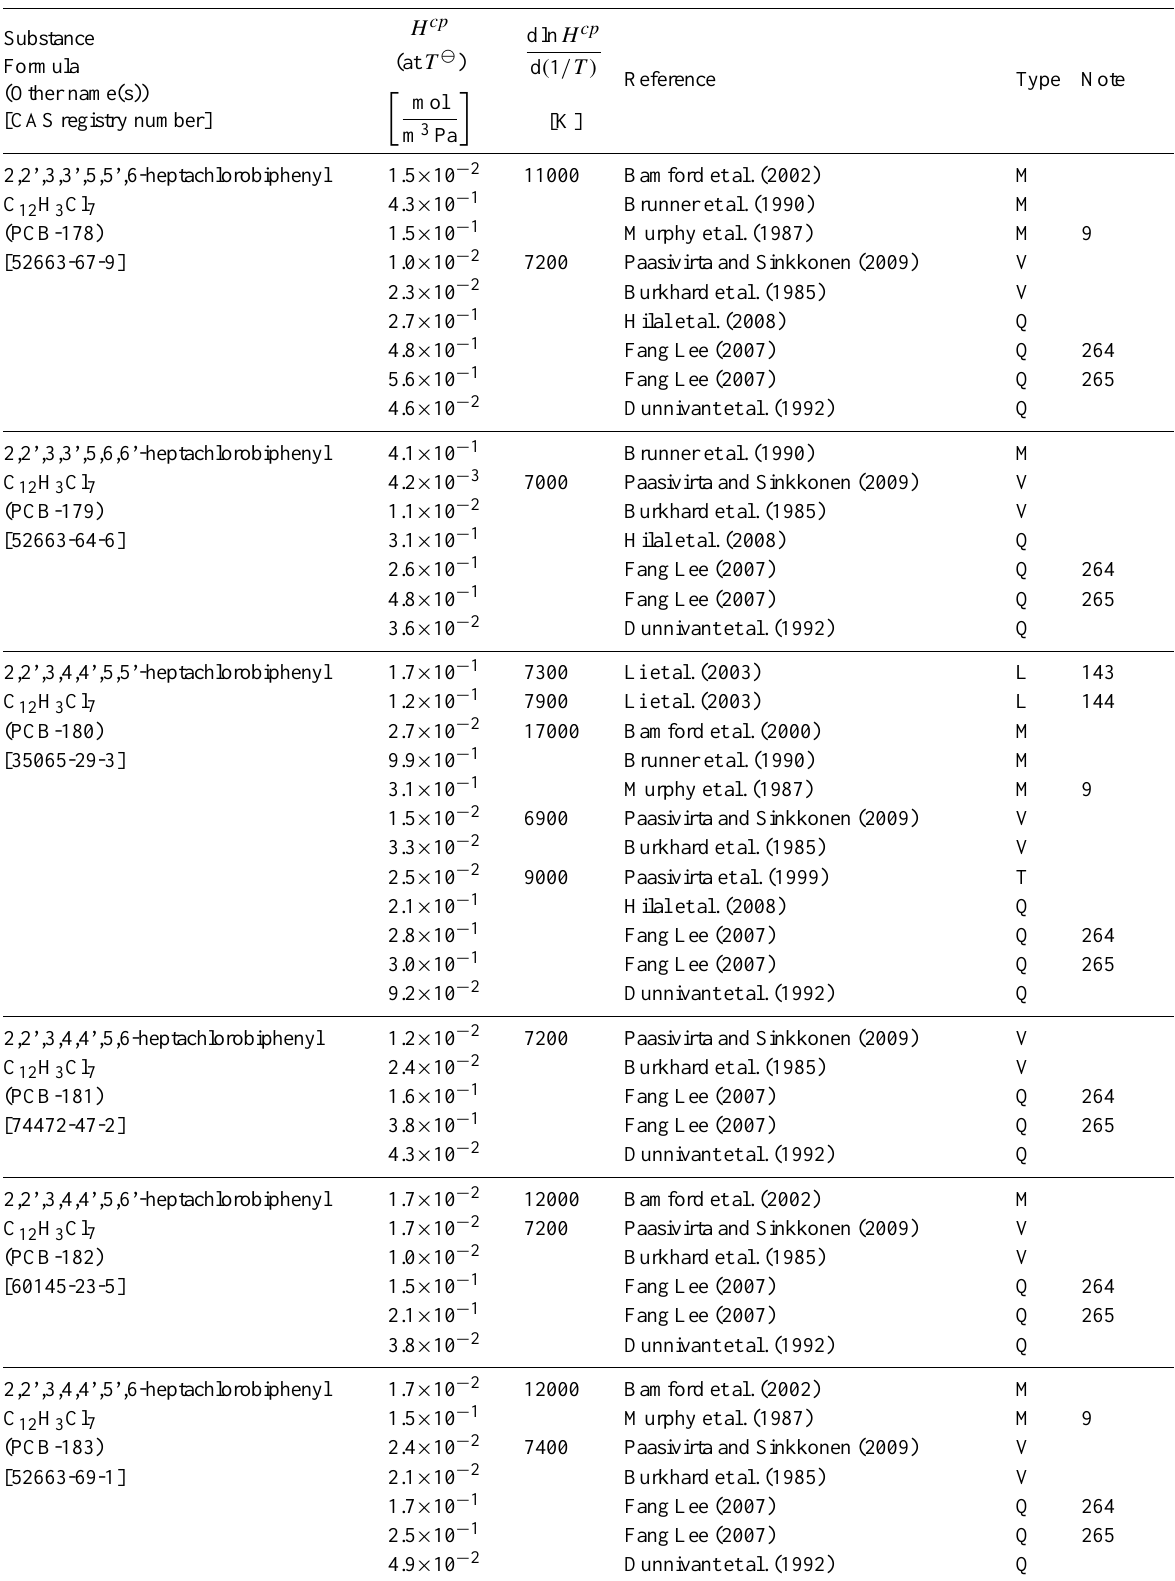
Table 6: Henry’s law constants for water as solvent